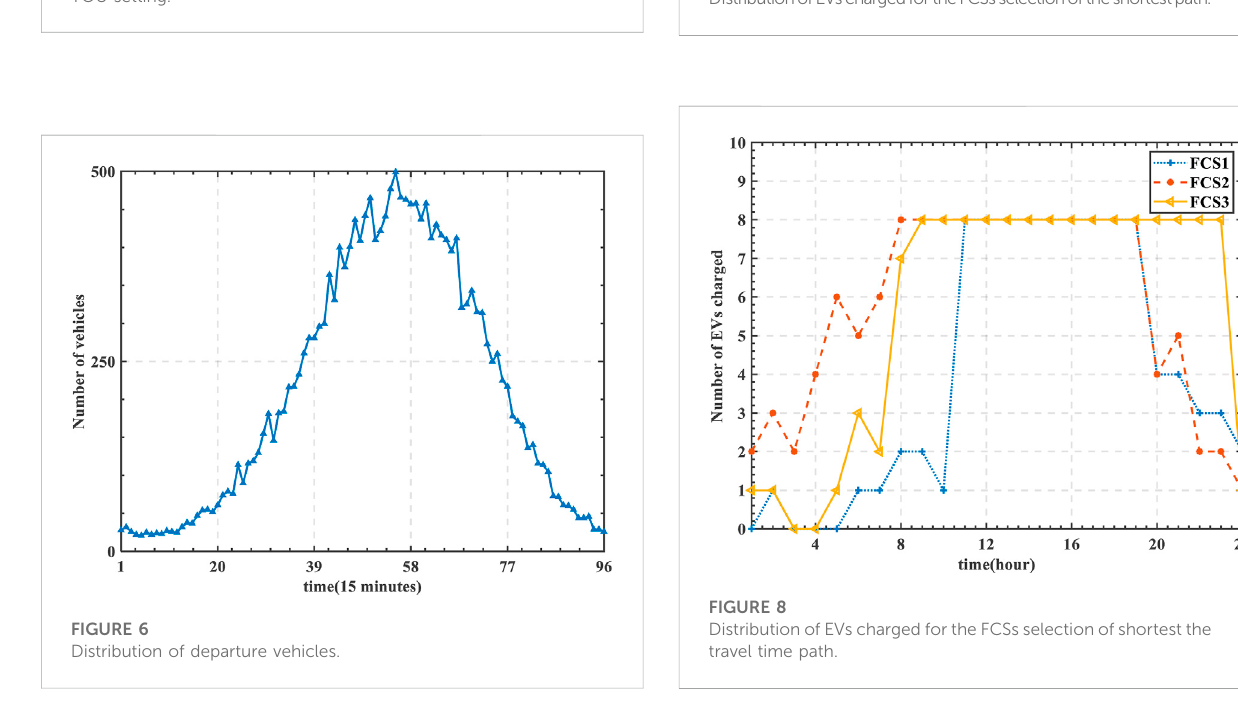
FIGURE 7 DistributionofEVschargedfortheFCSsselectionoftheshortestpath.